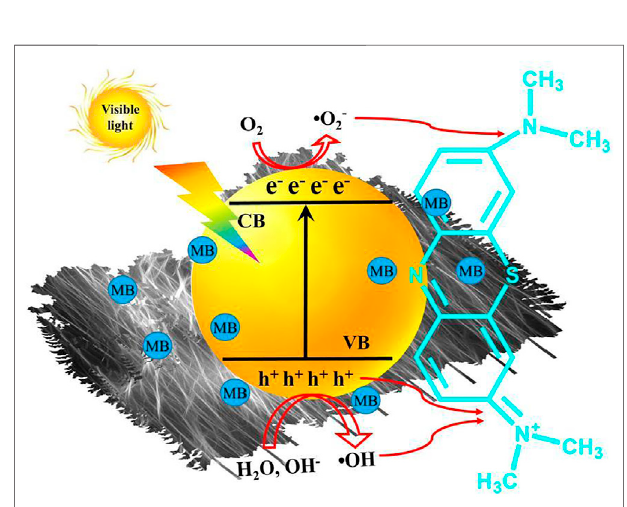
FIGURE 9 | MB degradation mechanism over CdS/MCC composite